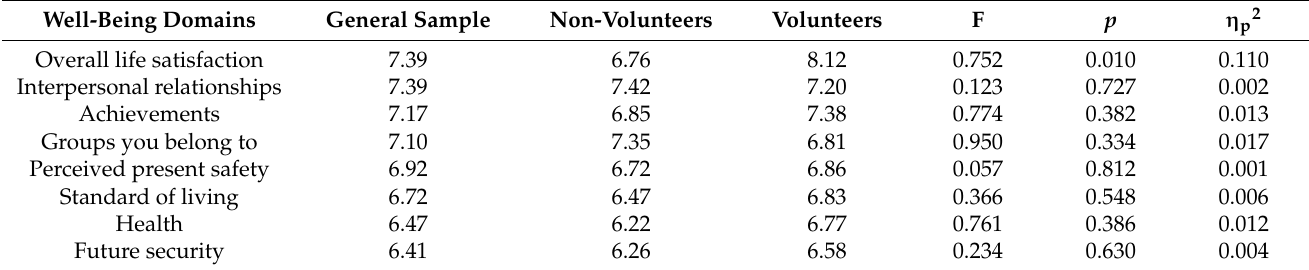
Table 4. Satisfaction with the different satisfaction domains included in the PWI. Scale from 0 to 10 (0 = totally dissatisfied and 10 = totally satisfied).